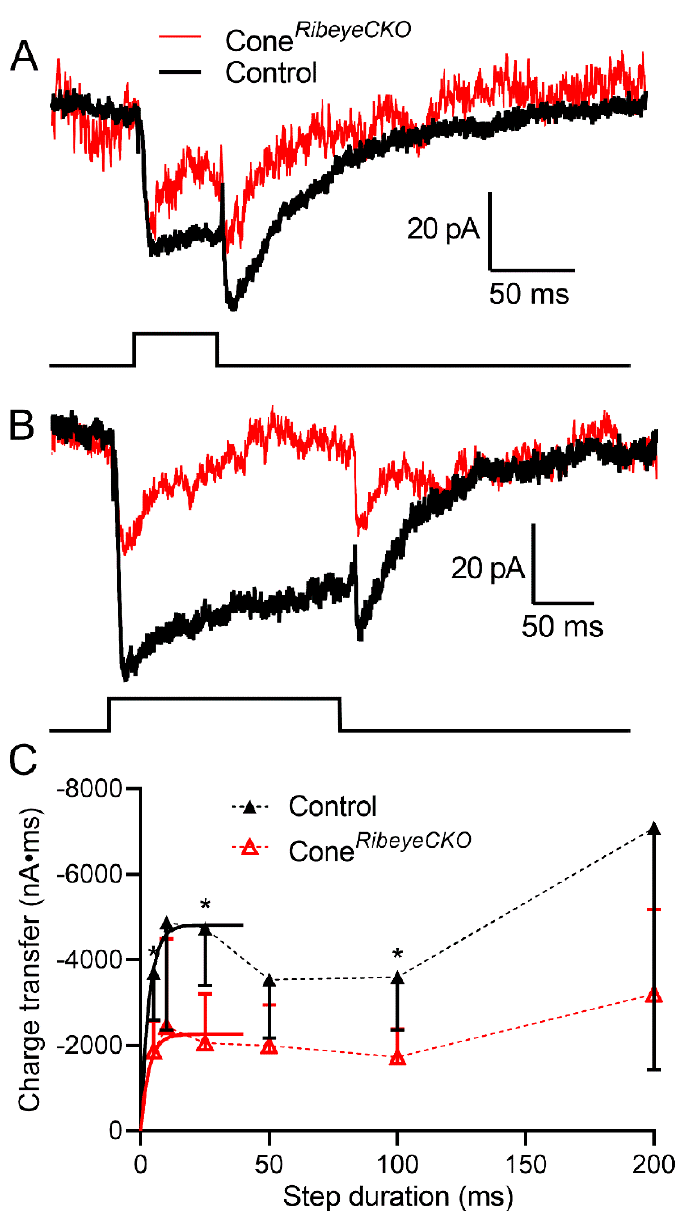
Figure 7. Eliminating cone ribbons halved the releasable vesicle pool. Example recordings of I A(glu) evoked by steps of 50 and 200 ms recorded from a cone in a control C57Bl6J retina (( A ), black traces) and a cone in a cone Ribeye CKO retina (( B ), red traces). ( C ). Plot of the I A(glu) charge transfer measured following steps of 5, 10, 25, 50, 100, and 200 ms from cones in the C57Bl6J ( n = 14–28 cells at each data point) and cone Ribeye CKO ( n = 5–18 cells) retinas. The data from 5–25 ms were fit with single exponentials yielding the best-fit amplitude of 4835 and 2182 pA*ms in the wild-type and Ribeye CKO cones, respectively. The best-fit time constants were 3.32 and 2.43 ms in the wild-type and Ribeye CKO cones, respectively. These did not differ significantly ( p = 0.83, F-test). The overall sample of responses to different test durations was significantly smaller in the cones lacking RIBEYE ( p < 0.0001, ANOVA). The differences were also significantly different at individual timepoints of 5, 25, and 100 ms (*: p <0.05; adjusted p -values, Holm–Sidak method for multiple comparisons, p = 0.0292, 0.0176, and 0.0347, respectively).